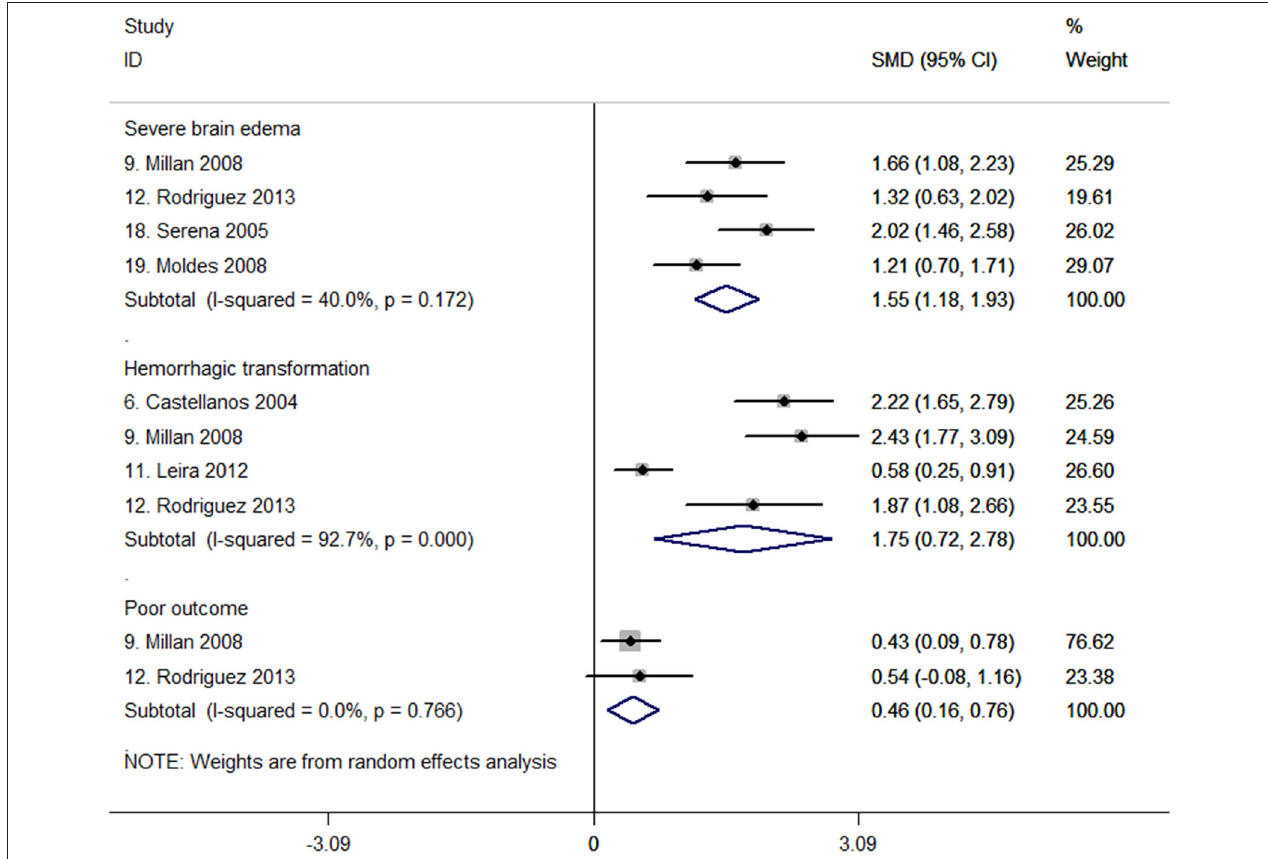
FIGURE 3 | Forest plots of standardized mean difference (SMD) in cellular fibronectin (c-Fn) levels between different patient